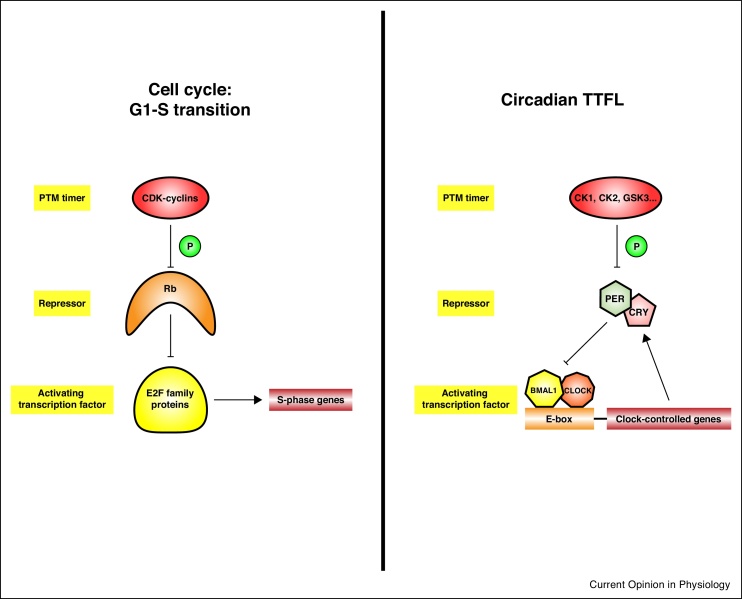
Comparing the circadian cycle to the cell cycle G1/S transition.A critical point for both the cell cycle and the circadian cycle is the activation of key transcription factors. This is achieved in both cases by the relief of repression by a negative regulator. The mechanism for this is phosphorylation: of Rb by cyclin-dependent kinases for the cell cycle, and of PER by CK1δ/ε for the circadian cycle. Hence the de-repression of crucial activating transcription factors via kinase activity is a common network motif for the temporal regulation of cellular processes.